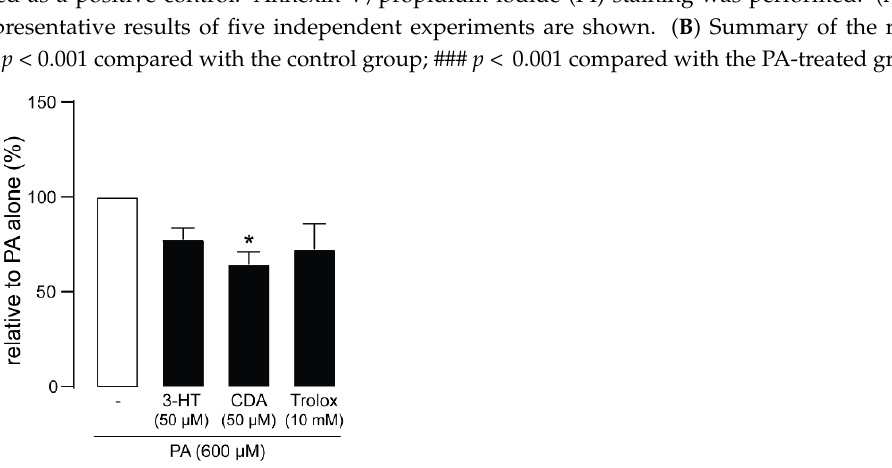
Figure 5. Effect of 3 ‐ hydroxyterphenyllin (3 ‐ HT) and candidusin A (CDA) on fluorescein isothiocyanate (FITC)–dextran leakage across the human podocyte monolayer. Podocytes were plated on a porous membrane and grown until confluence. Podocytes were treated with palmitic acid (PA) for 24 h with or without 50 μ M 3 ‐ HT or CDA. Trolox (10 mM) was used as a positive control. FITC ‐ dextran was added to the lower compartment, and its concentration in the upper compartment was measured after 120 min as an indicator of podocyte barrier leakage. The data are expressed as the mean of FITC ‐ dextran concentrations relative to control (PA ‐ treated) group ± standard error of the mean. * p < 0.05 compared with the PA ‐ treated group.